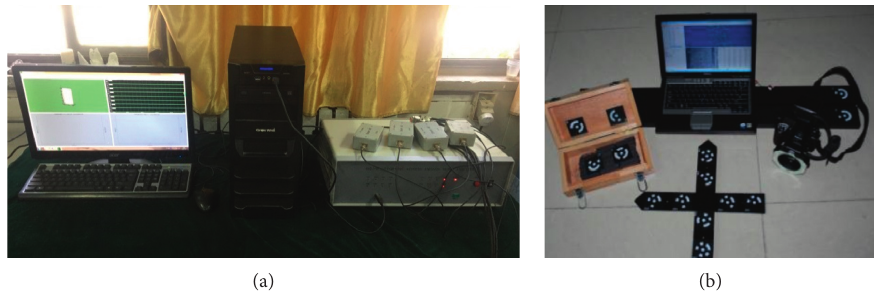
Figure 3: Experimental equipment. (a) AE data acquisition system. (b) Hardware composition of XJTUDP.